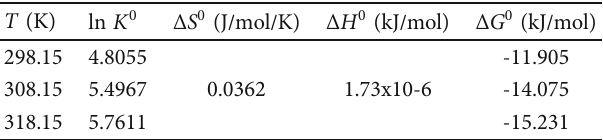
Figure 5: The fi tting of adsorption data to the Langmuir model (a), the Freundlich model (b), pseudo 1 st order (c), and pseudo 2 nd order for the adsorption of MO dye on the surface of MOF/NH Table 2: The thermodynamic parameters for the adsorption of MO on the surface of MOF/NH2/Fe3O4